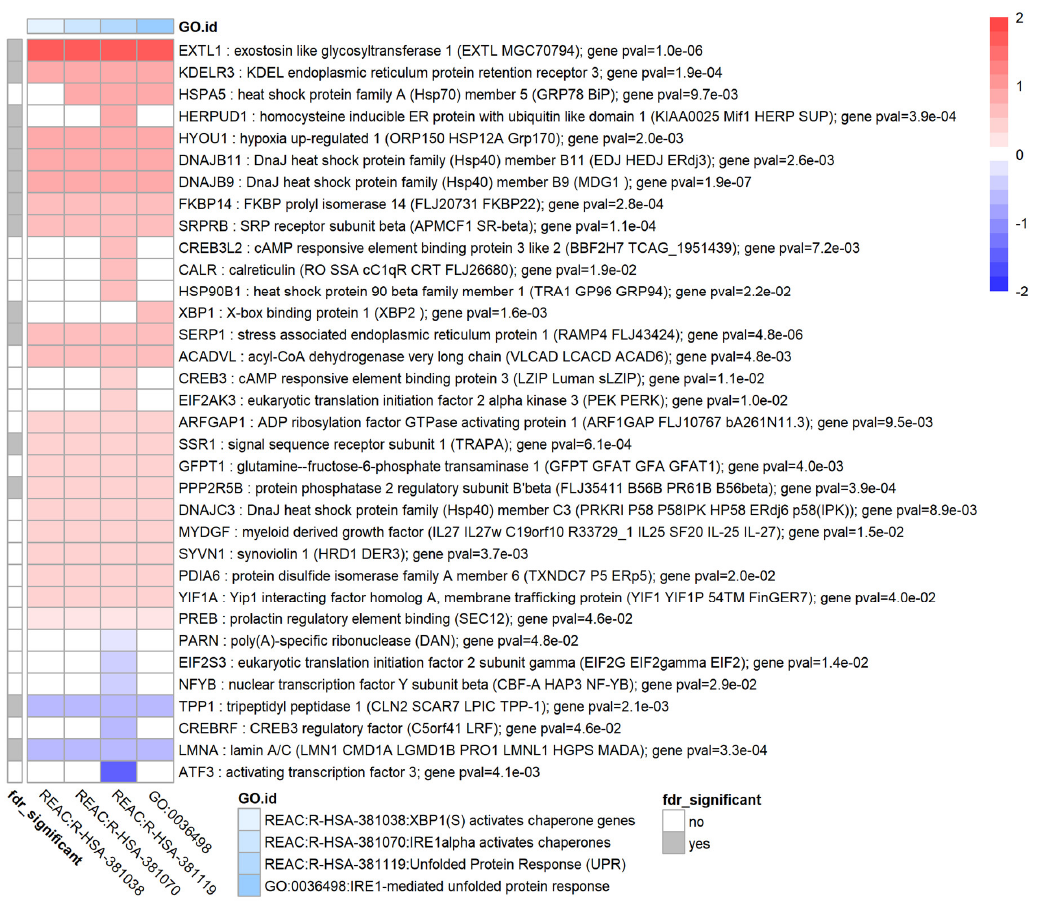
Figure 8. Enrichment results and genes associated with Unfolded Protein Response. Heatmap showing the genes with nominal p -value p < 0.05 for genes associated with the unfolded protein response (UPR). Heatmap colours correspond to fold change expressed as log 2 FC which has been limited to a range of [-2, 2] for clarity. The grey annotation bar on the left shows if the genome-wide false discovery rate FDR is smaller than 0.05 (in which FDR is the BH corrected p -value) for a particular gene. To further improve clarity, only 4 enriched terms within this cluster are shown.